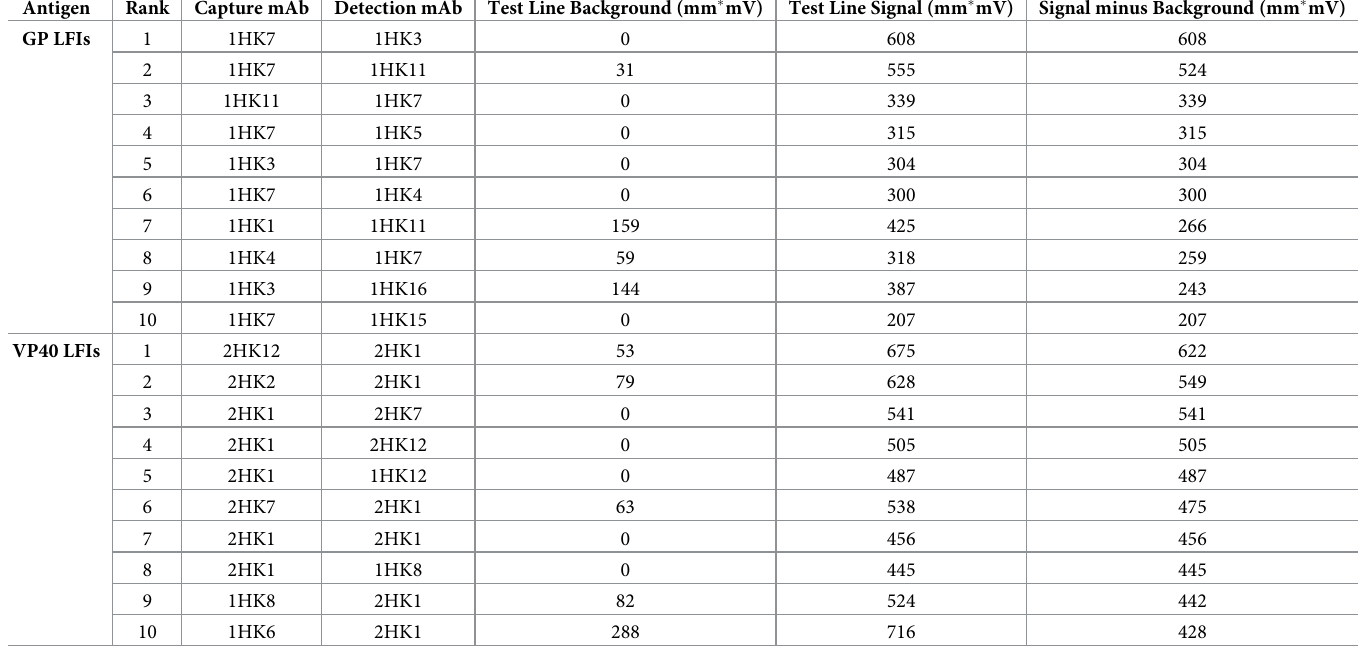
Table 2. Reactivity of top performing monoclonal antibody (mAb) pairs when evaluated in lateral flow immunoassay (LFI) format with target antigen spiked into buffer. Antigen Rank Capture mAb Detection